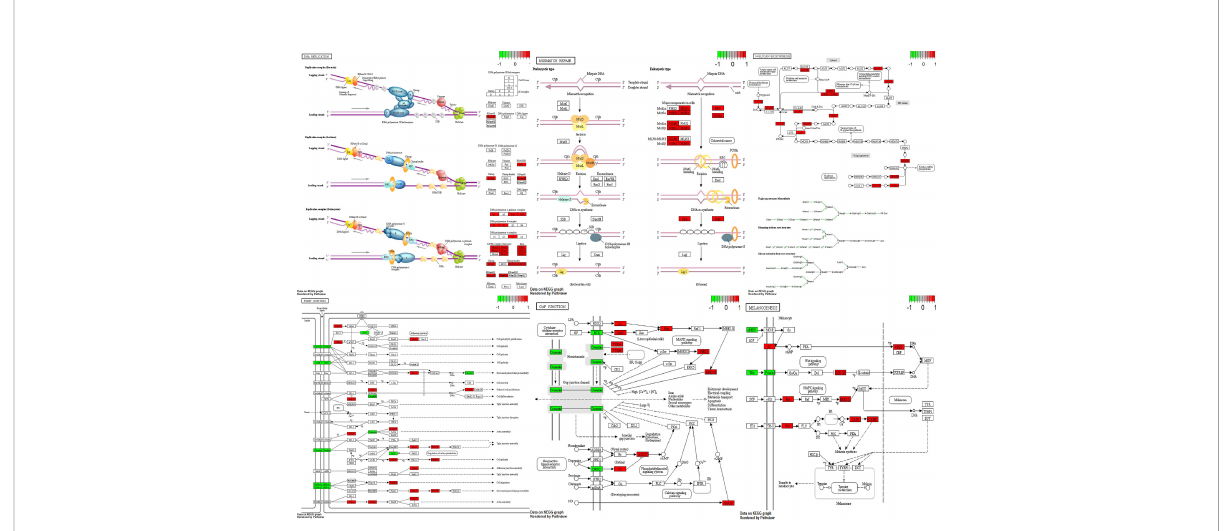
FIGURE 7 Visualization of pathways. Green boxes are downregulated genes and red boxes are upregulated